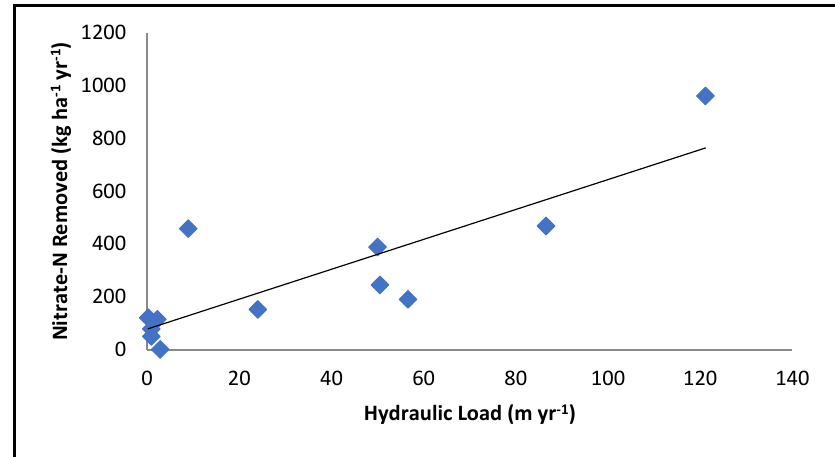
Table 1. Mass removal of nutrients in floodplains. Annual mass reductions in nitrate-N (NO 3− -N) and total or particulate phosphorus (TP or particulate P) loads in floodplains from literature reviewed.